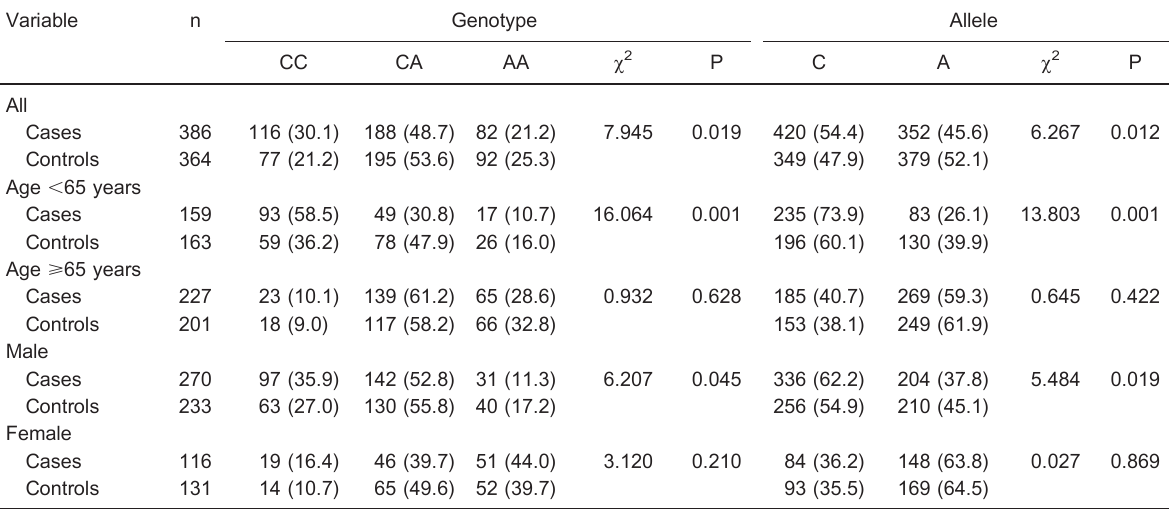
Table 2. Genotype and allele frequencies for the IL-18 -607C/A (rs1946518) locus in patients with ischemic stroke and controls.